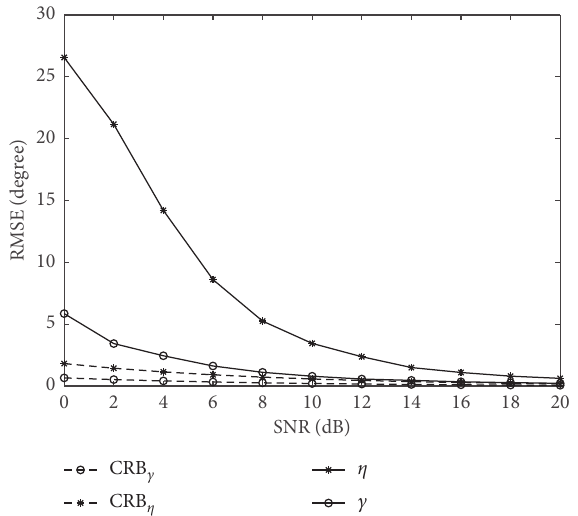
Figure 12: RMSE of polarization parameters with different